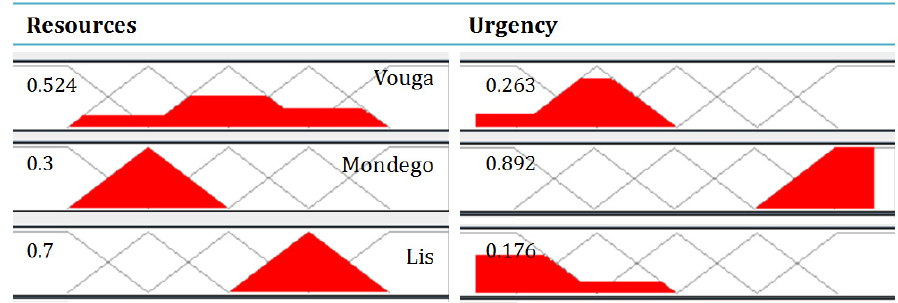
Figure 10. Defuzzification step using the FISPRO program.